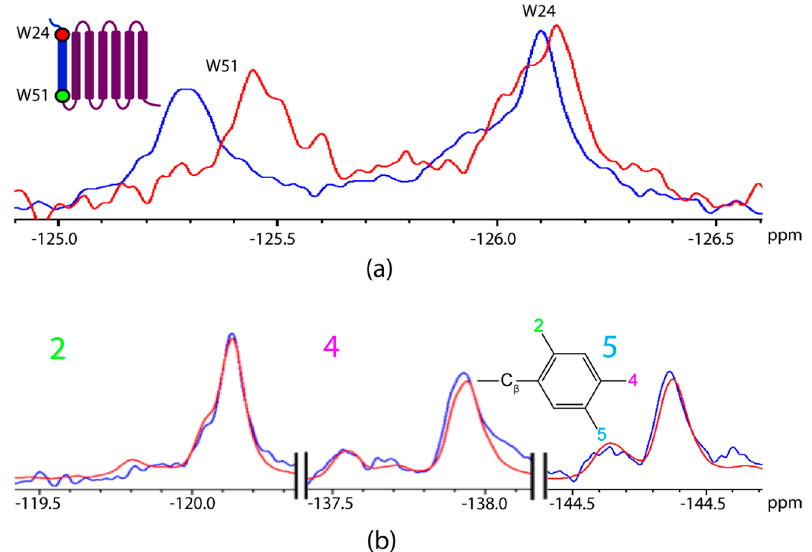
Figure 5. 19 F NMR spectral regions for ( a ) 4F-Trp-labelled AR55 ( b ) F*-ap-13. Experiments are compared for each species alone (blue) and at 1:1 ligand: receptor stoichiometry (red). Table 1. 19 F chemical shift perturbation ( ∆ δ ) relative to control sample in absence of binding partner for AR55:F*-ap-13